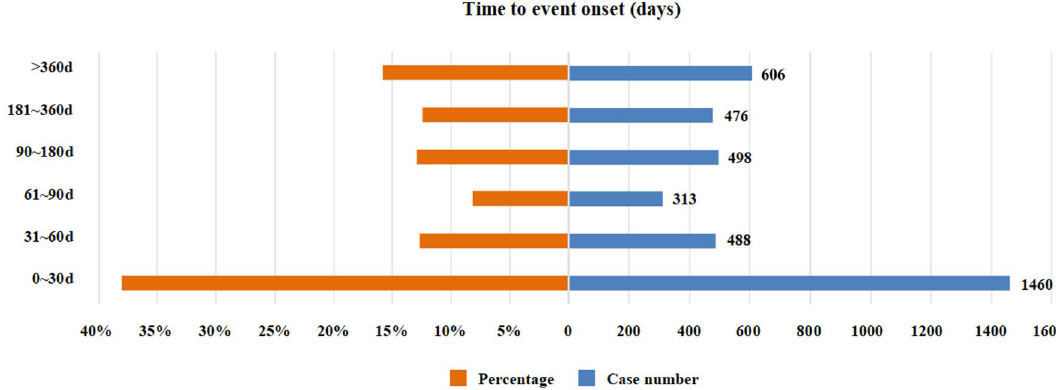
Figure 1. Time to onset of osimertinib-related AEs.